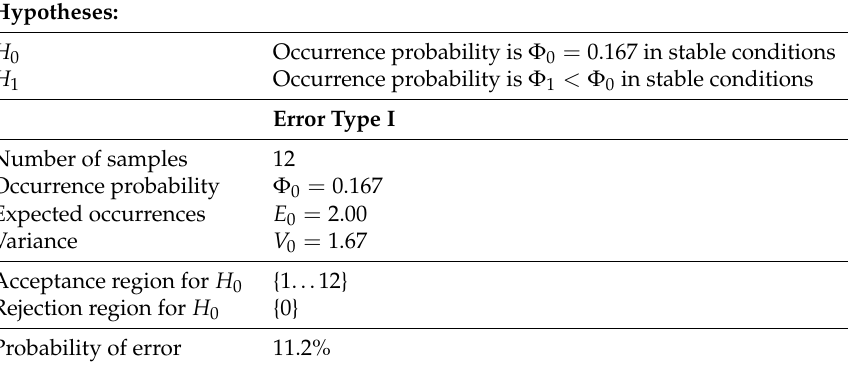
Table 4. Error estimation for the occurrence of non-Gaussian turbulence for onshore stable conditions.